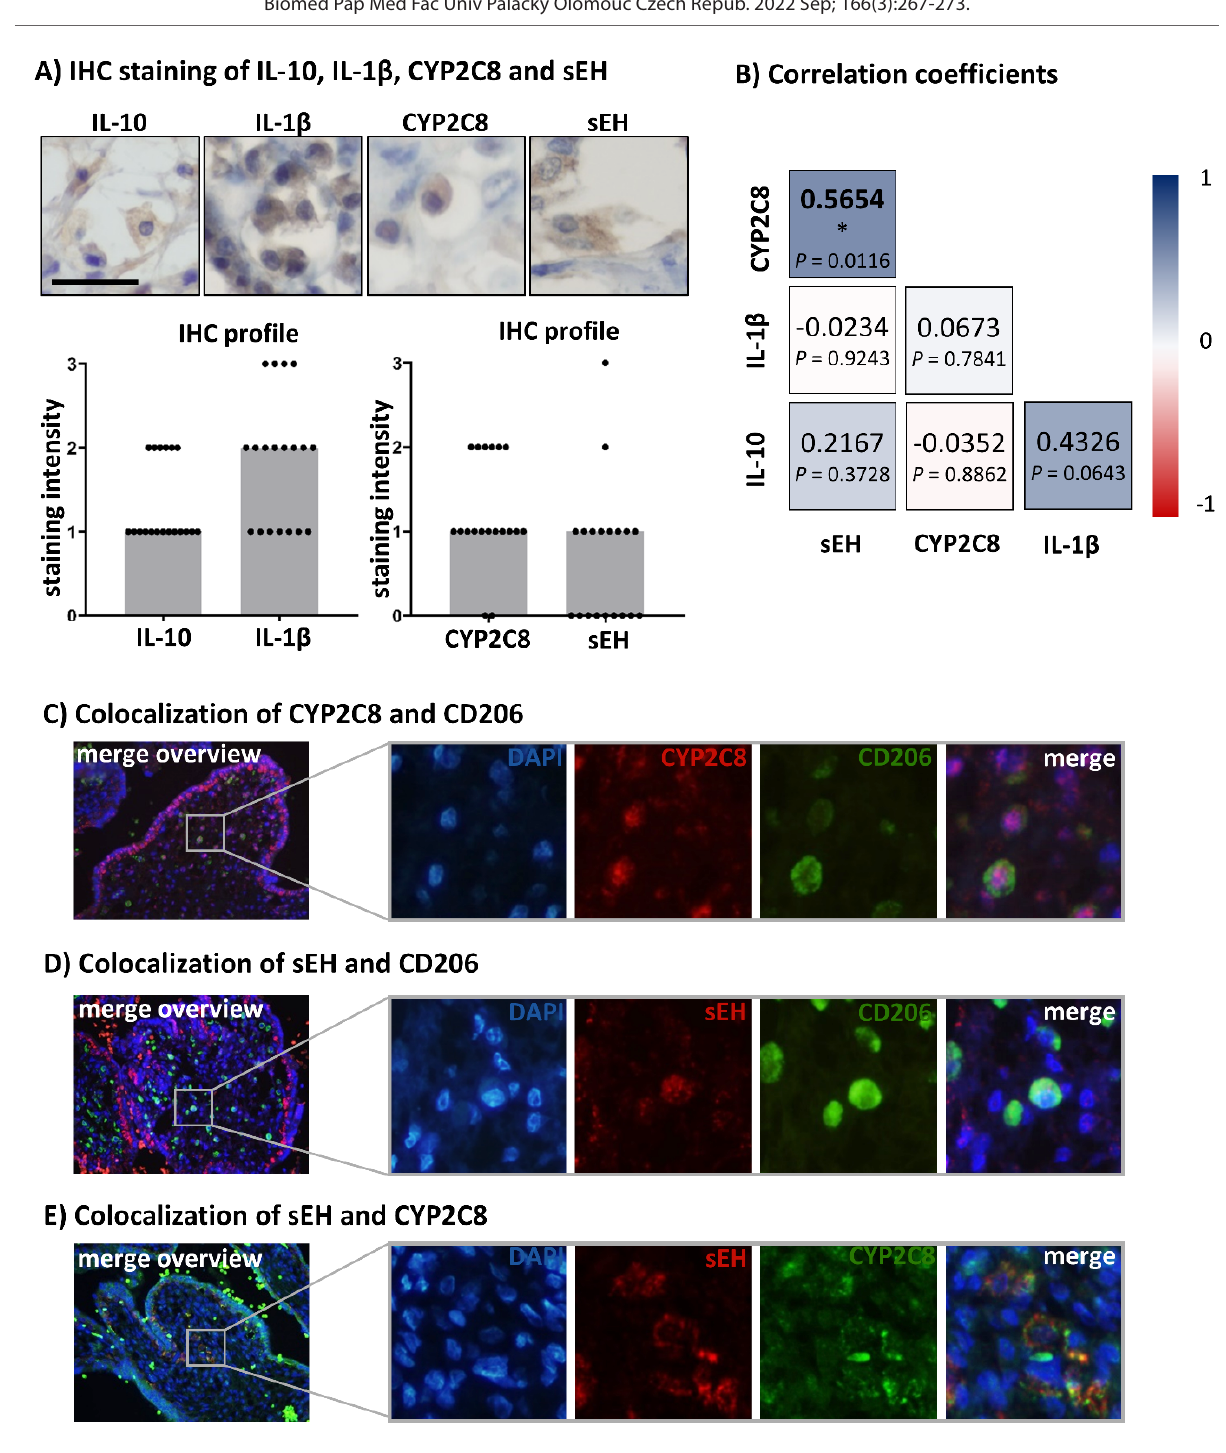
Fig. 1A. Expression of IL-10, IL-1β, CYP2C8 and sEH in Hofbauer cells in placenta with chorioamnionitis. Microphotographs show HBCs located in stromal channels, magnification 400x, black line represents 20 μm. Staining intensity was evaluated as: negative (0), weak (1), moderate (2) and strong (3). Distribution of staining intensities is shown as points in the graphs (one point represents one sample; n = 19). Columns show medians. 1B. Spearman correlation coefficients and P values, statistically significant results are marked by * P < 0.05. 1C. Multiplex immunofluorescent staining for proof that stromal cells expressing CYP2C8 are HBCs, detected by CD206 (marker of M2 macrophages). 1D. Multiplex immunofluorescent staining for proof that stromal cells expressing sEH are HBCs, detected by CD206 (marker of M2 macrophages). 1E. Multiplex immunofluorescent staining for proof that CYP2C8 and sEH are expressed in the same HBCs. Magnification of overview figures is 100x, details